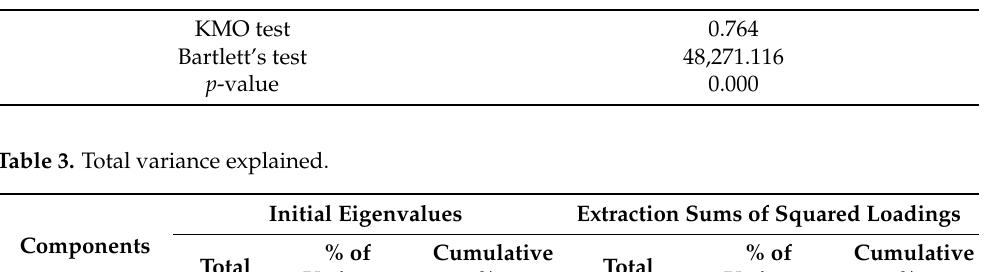
Table 2. Results of the KMO and Bartlett’s tests.